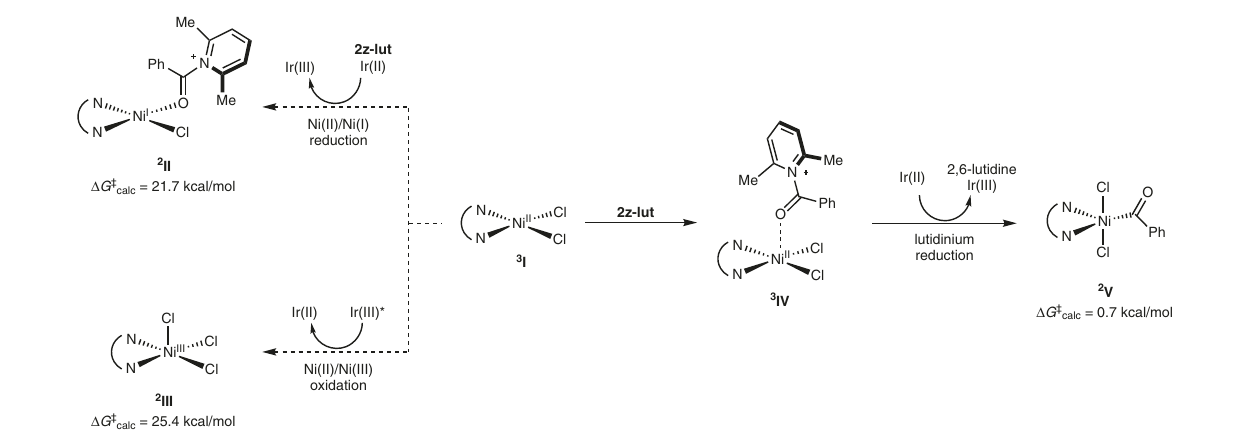
practically barrierless (0.7kcal/mol), outcompeting other redox pathways invol- ving the nickel precatatlyst 3 I